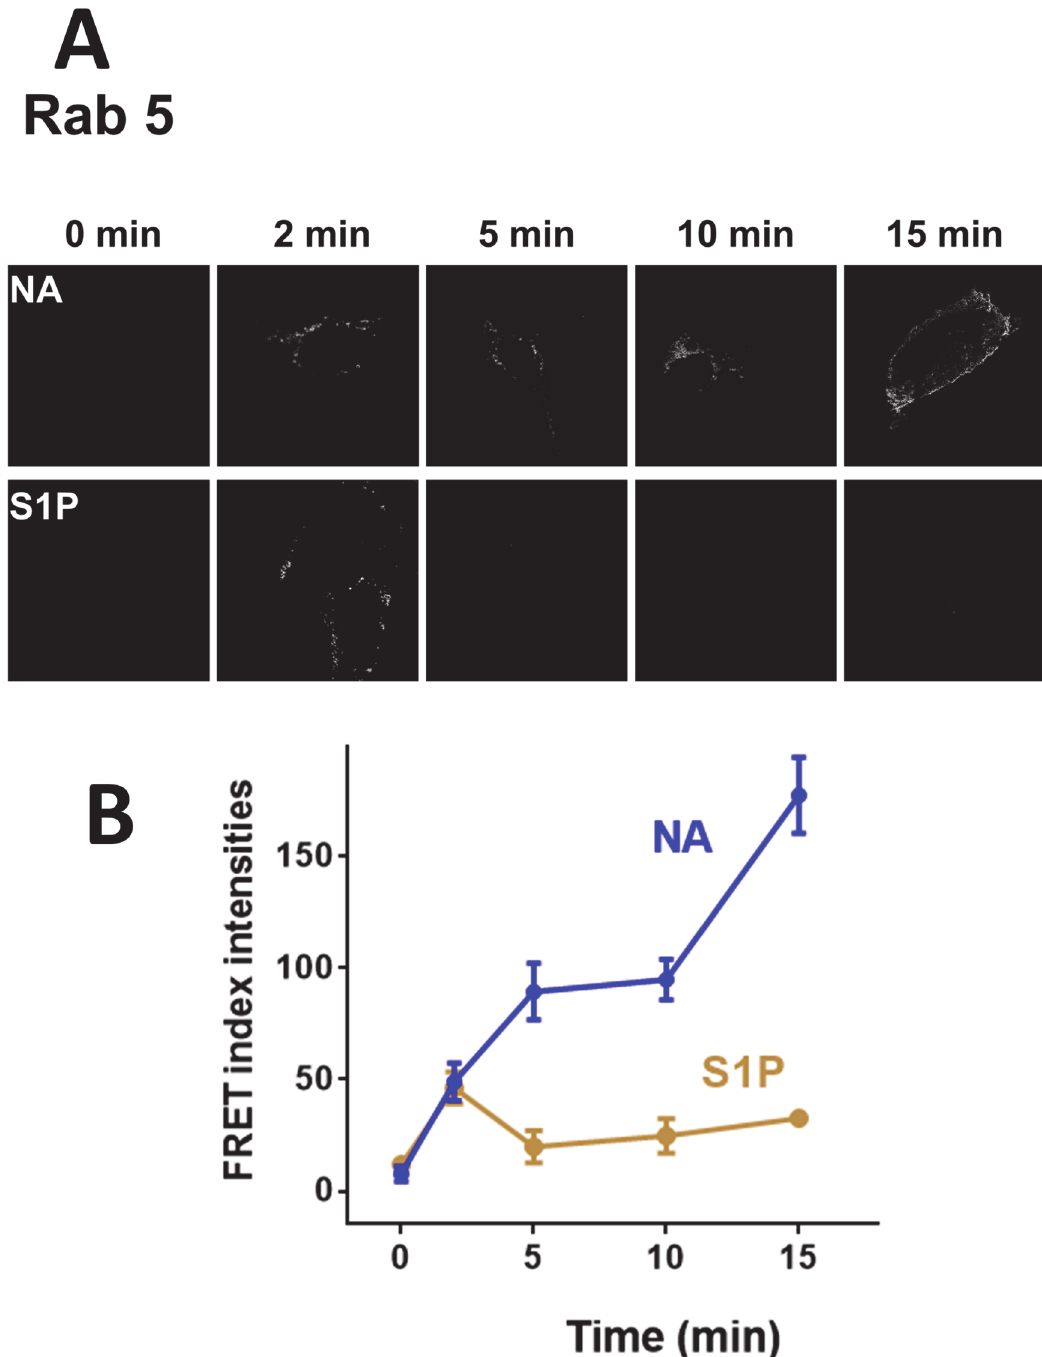
Fig 10. Time-course of the α 1B -adrenergic receptor-Rab 5 interaction. Panel A: FRET index images of cells coexpressing Ds-Red-tagged α 1B - adrenergic receptors and EGFP-tagged Rab 5 treated for the times indicated with 10 μ M noradrenaline (NA) or sphingosine 1-phosphate (S1P). Scale bars: 15 μ m. Panel B: Quantitative analysis of the data presented in Panel A. Plotted are the means and vertical lines representing the S.E.M of 5 – 7 experiments using different cell preparations. Noradrenaline, blue line and symbols; sphingosine 1-phosphate, brown line and symbols.